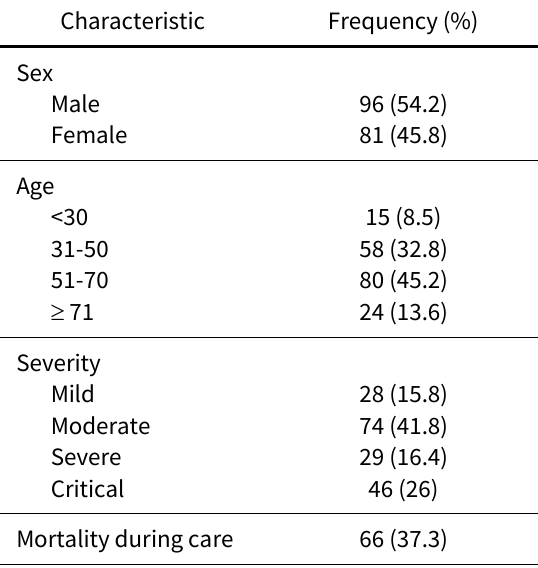
Table 1 . Demographic Data of COVID-19 Patients